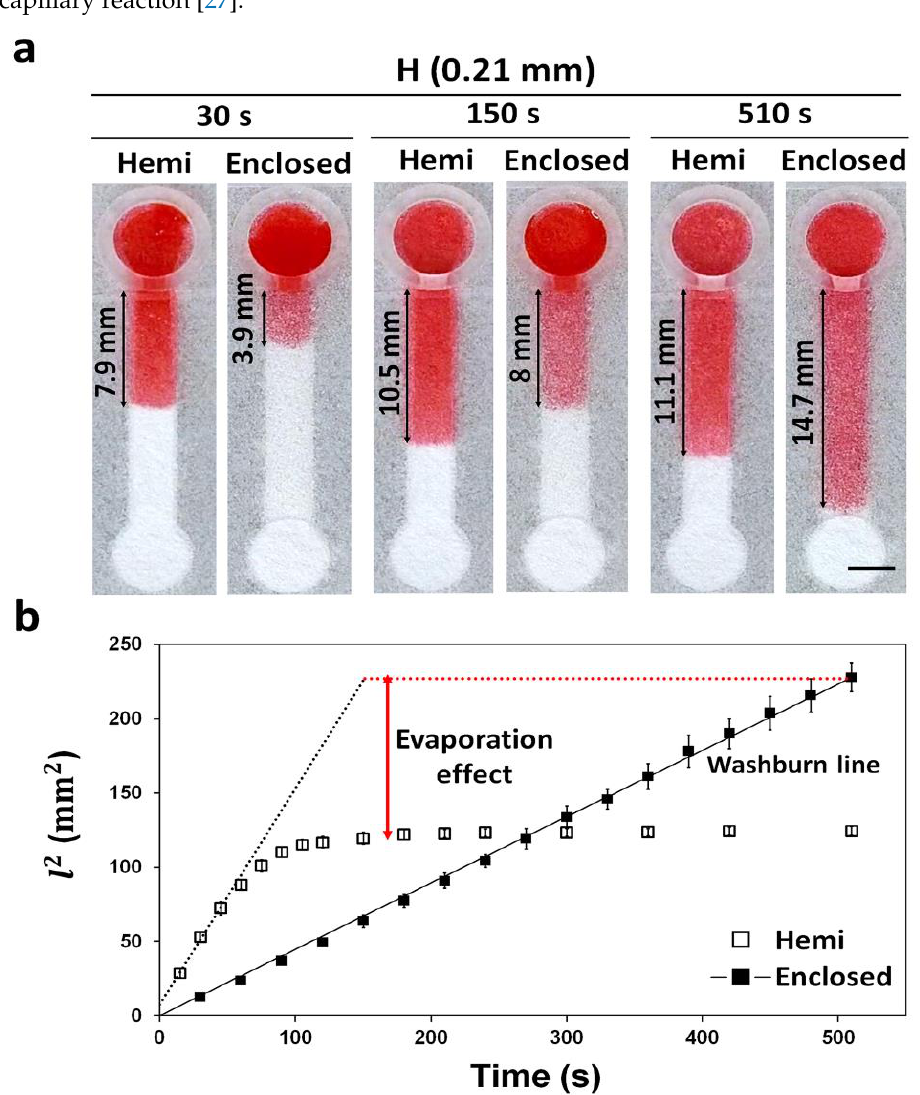
Figure 5. Wicking distance and evaporation effect in hemi and enclosed channels with the same height (0.21 mm) during the time (0–510 s). ( a ) Wicking of a red dye solution (10 μL) in the channels at 30, 150, and 510 s. Scale bar: 3 mm. ( b ) Different wicking speed profiles over time explaining the difference in evaporation between the hemi and enclosed channels. The Washburn line was obtained by the Lucas–Washburn equation (Equation (1)) [27]. The experiment was carried out at 28 °C and a relative humidity of 41%. n = 3.